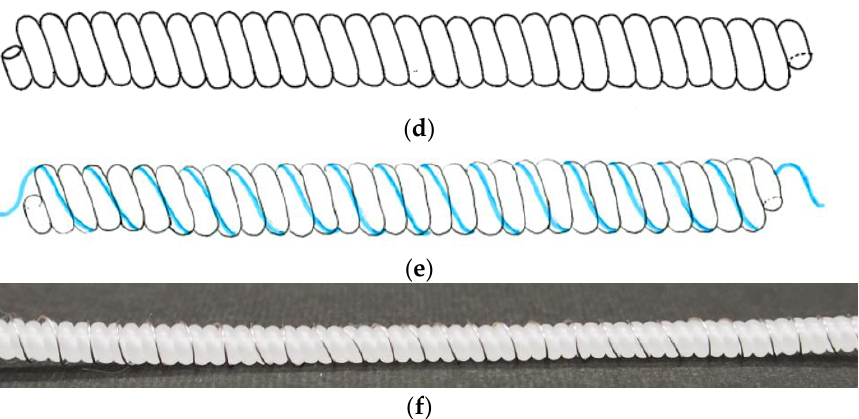
Figure 1. Order of creation of TCPA with nylon fishing line. ( a ) Nylon fishing line cut to specified length. ( b ) Twisting with tension acting on the fiber. ( c ) Coiled from fiber ends. ( d ) Continued torsion results in a coiled shape over the entire fiber length. ( e ) Wrap stainless steel fiber around TCPA for heating. ( f ) Completed TCPA.